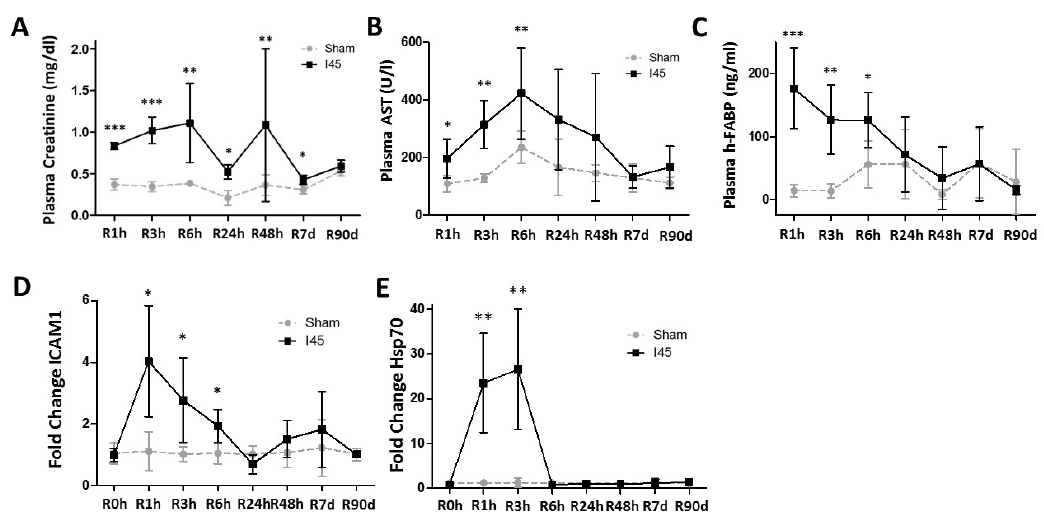
Figure 1. Kidney function is reduced, injury is increased, and tissue inflammatory processes are activated after mild ischemia and reperfusion. Rats, either Sham-operated (Sham) or subjected to 45 min of renal ischemia (I45), were sacrificed at various time points post reperfusion (R0h, R1h, R3h, R6h, R24h, R48h, R7d, and R90d). Plasma was collected to measure the creatinine ( A ), aspartate aminotransferase (AST) ( B ), and heart-fatty acid binding protein (h-FABP) ( C ). Kidneys were collected and analyzed for the mRNA expression of intracellular adhesion molecule-1 (ICAM-1) ( D ) and heat shock protein 70 (Hsp70) ( E ). * p < 0.05, ** p < 0.01, *** p < 0.001. N = 6.